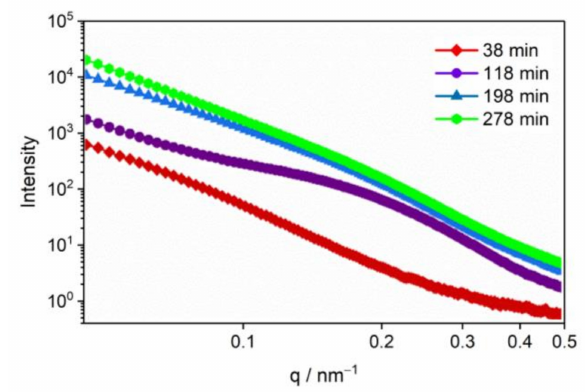
Figure 7. SAXS curves of CL-20 over time at 200 ◦